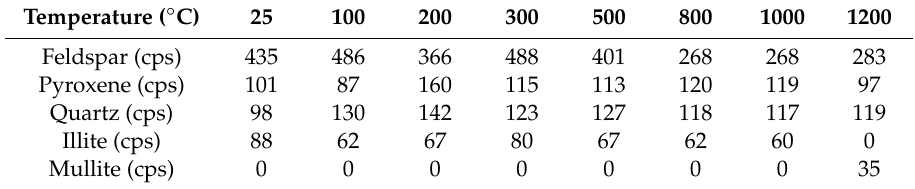
Table 2. Mineral contents of granite specimens at different temperatures.